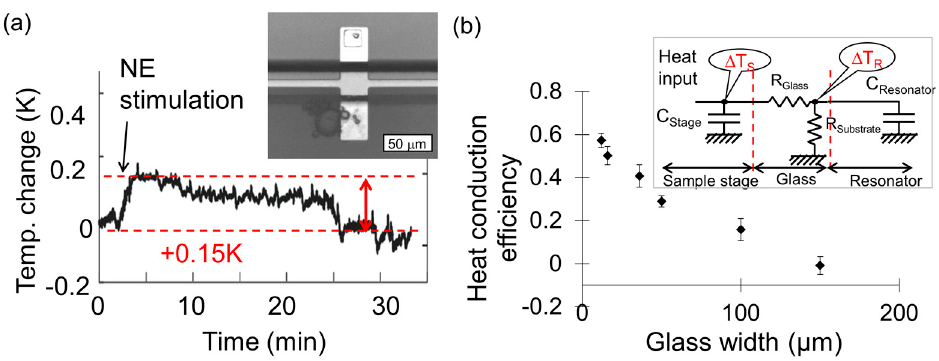
Figure 4. ( a ) Optical micrograph of the fabricated device and the sketch of the cross-section; ( b ) Temperature change of the BFCs after adding NE. The inset shows the BFCs attached to the sample stage, adopted from [83].